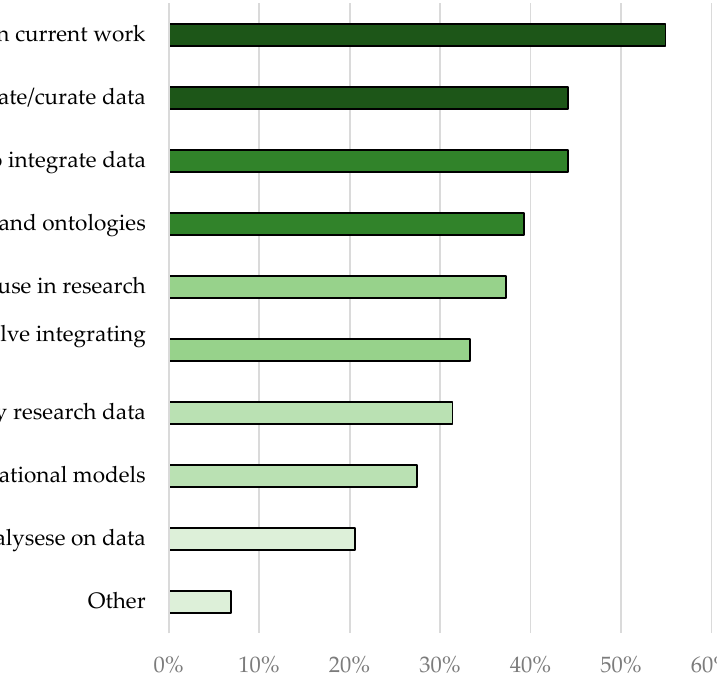
Figure 2. Research areas and disciplines of September 2021 EHLC workshop participants.